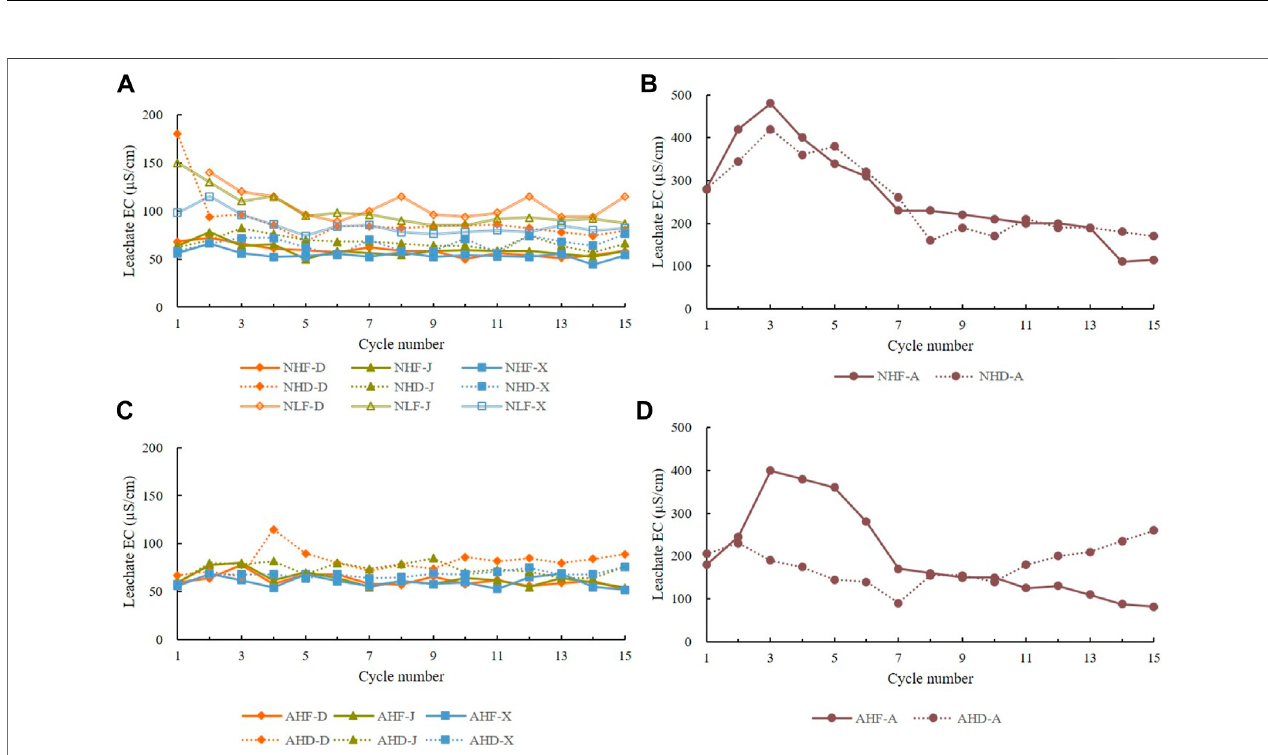
FIGURE 6 | Change of leachate electrical conductivity over 15 cycles. (A) D, J, and X under natural rain treatments; (B) A under natural treatments; (C) D, J, and X under acid rain treatments; (D) A under natural treatments. Codes oftreatments are N — natural rain and A — acid rain; H — high intensity and L — low intensity; D — drying temperature and F — freezing temperature; D sample from Datang badlands, China; J sample from Jiangtian badlands, China; X sample from Xiahui badlands, China; A sample from Araguás badlands, Spain.